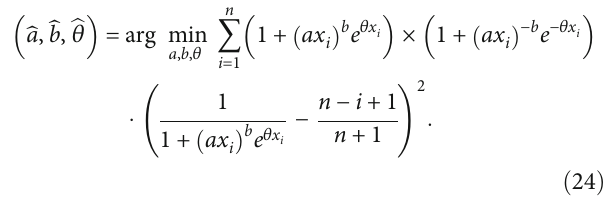
Figure 4: The TTT plot (a) and LLP (b) for data set of Table